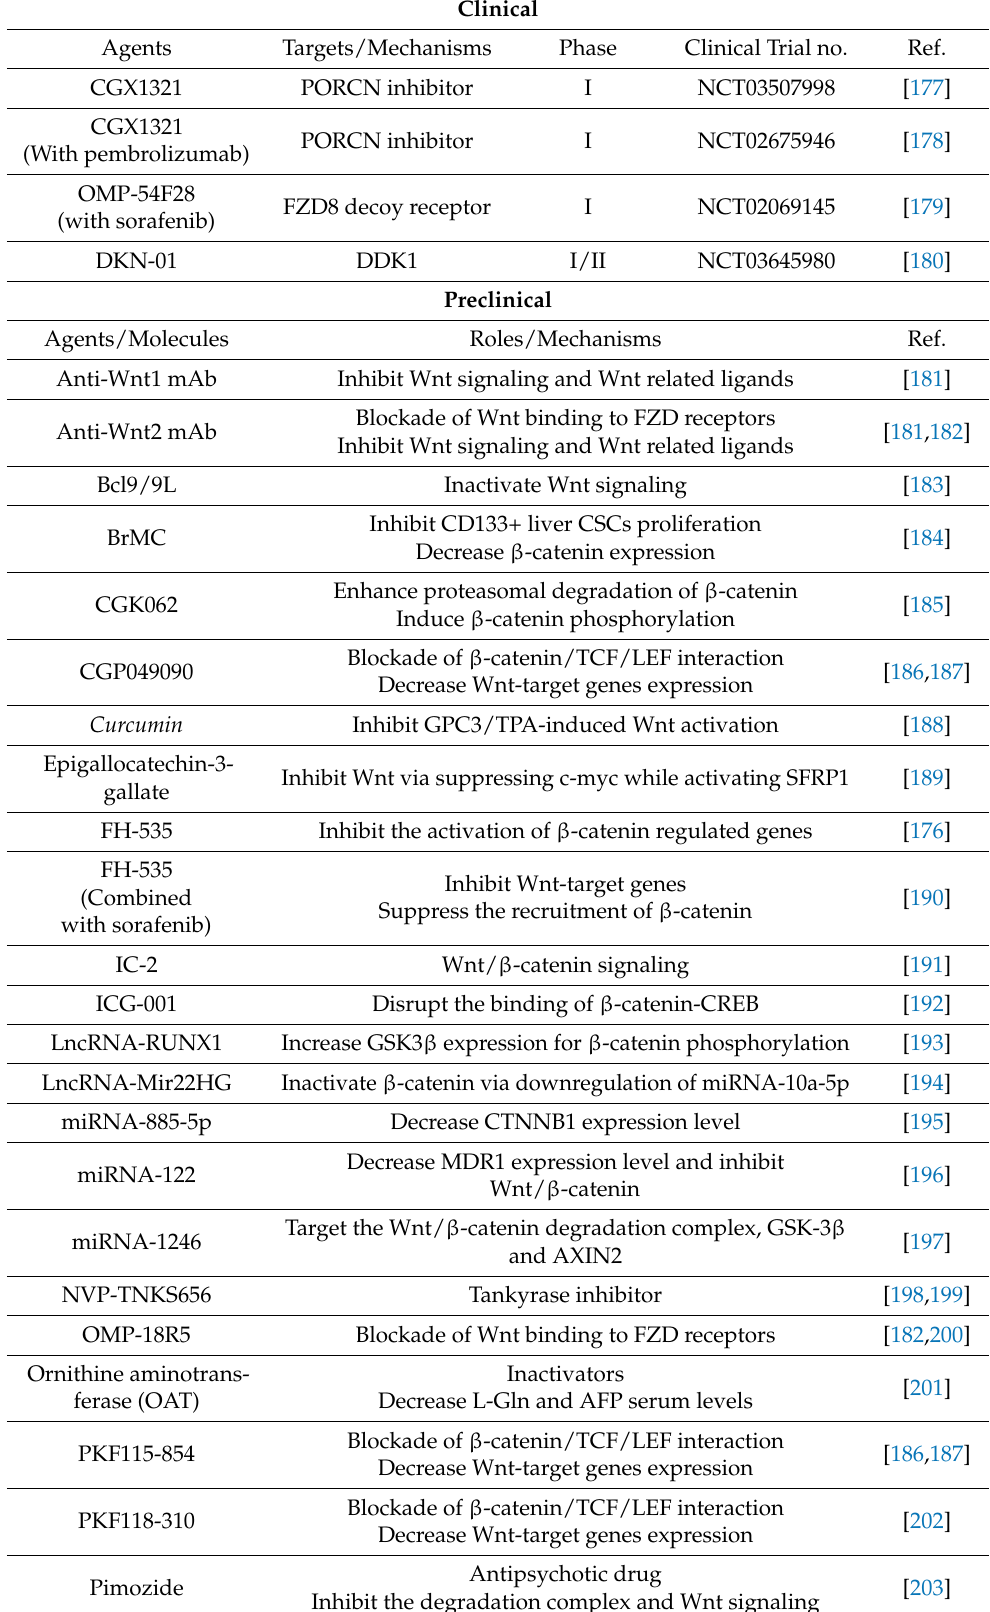
Table 2. Preclinical and clinical studies on targeting Wnt/ β -catenin signaling pathway in